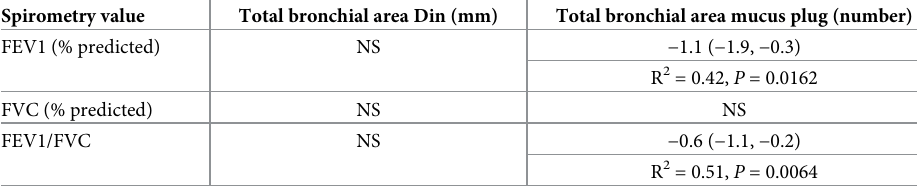
Table 2. The relationship between the airway diameter, mucus score, and spirometry